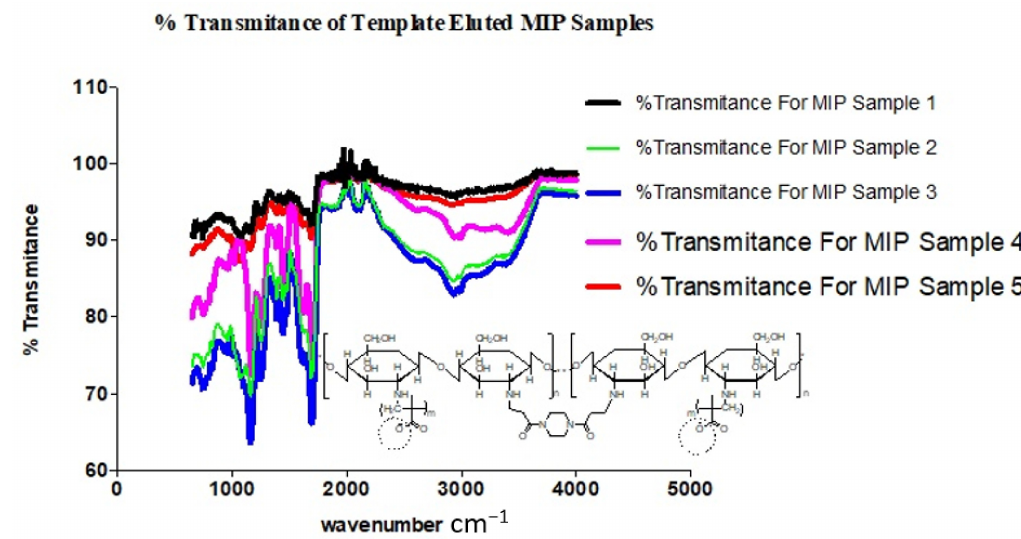
Figure 8. Spectra chart of % transmittance for template-eluted MIP samples.